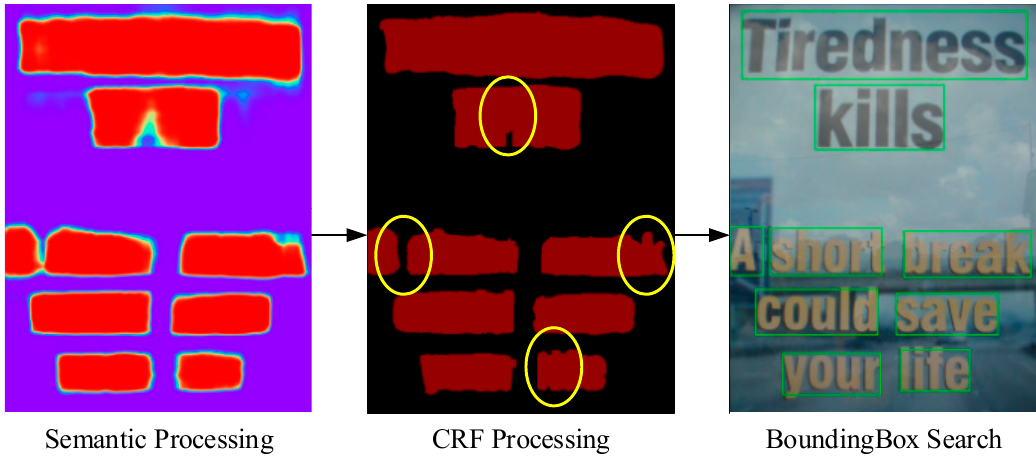
Figure 6. Semantic bounding box module flow chart. The yellow circle areas in the figure are clearer in the text boundary portion after the CRF processing.